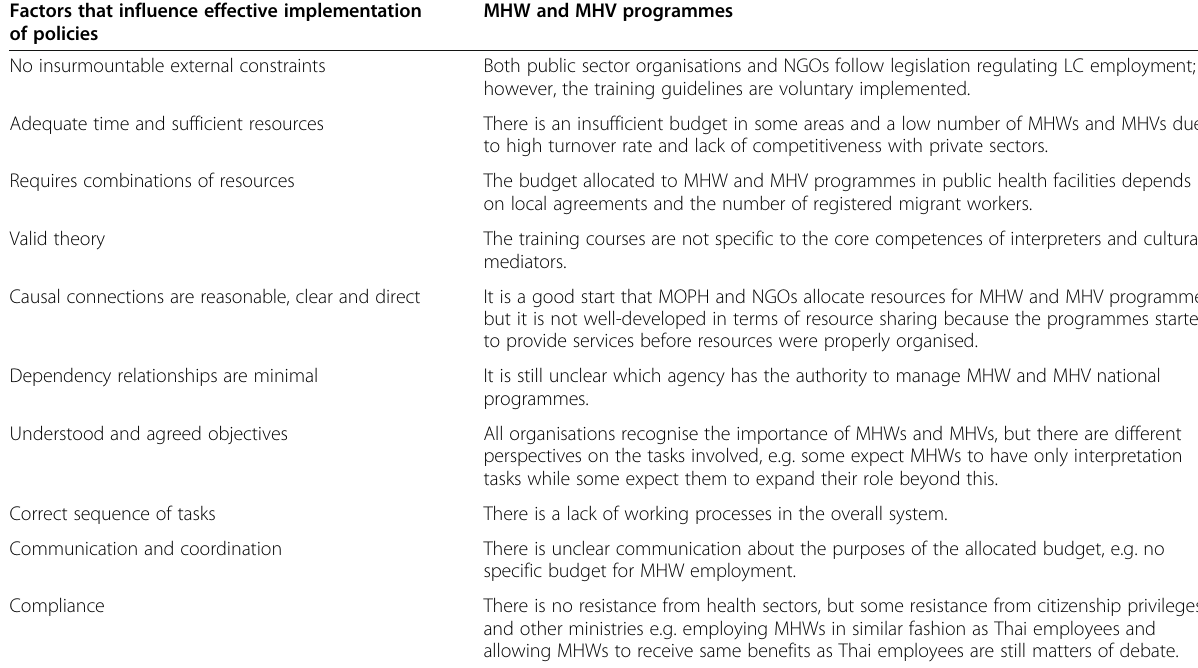
Table 5 Factors affecting policy implementation of MHV and MHW programmes in